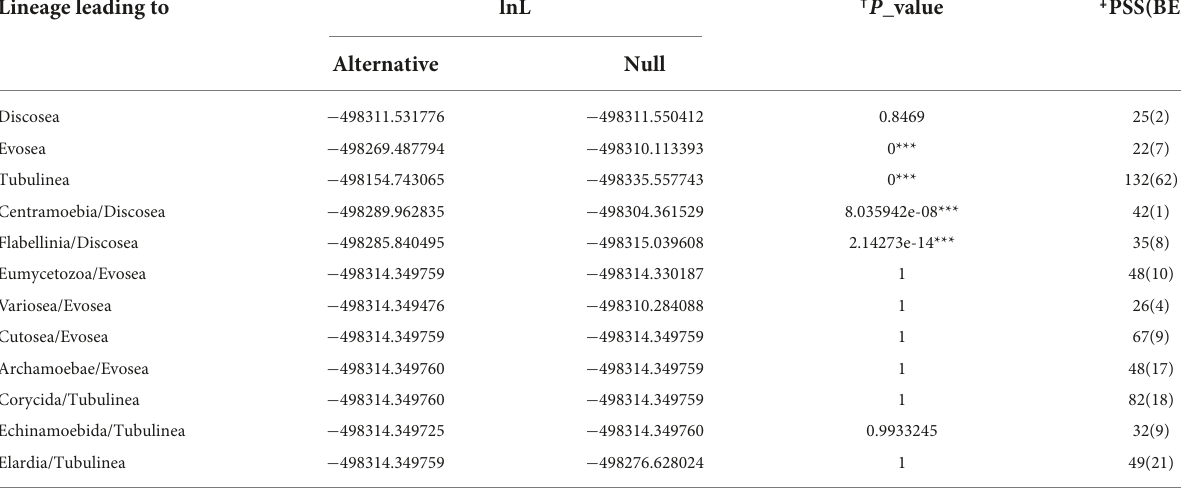
TABLE 3 Results of likelihood ratio tests and numbers of positively selected sites from BEB using branch-site models. Lineage leading to